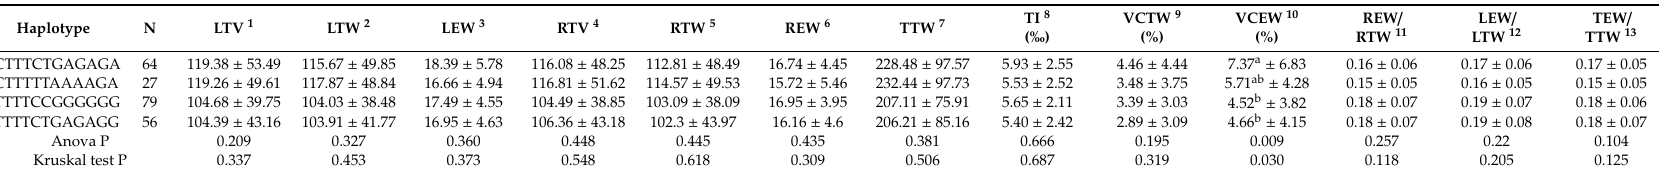
Table 5. Association analysis between di ff erent haplotypes and testicular traits.